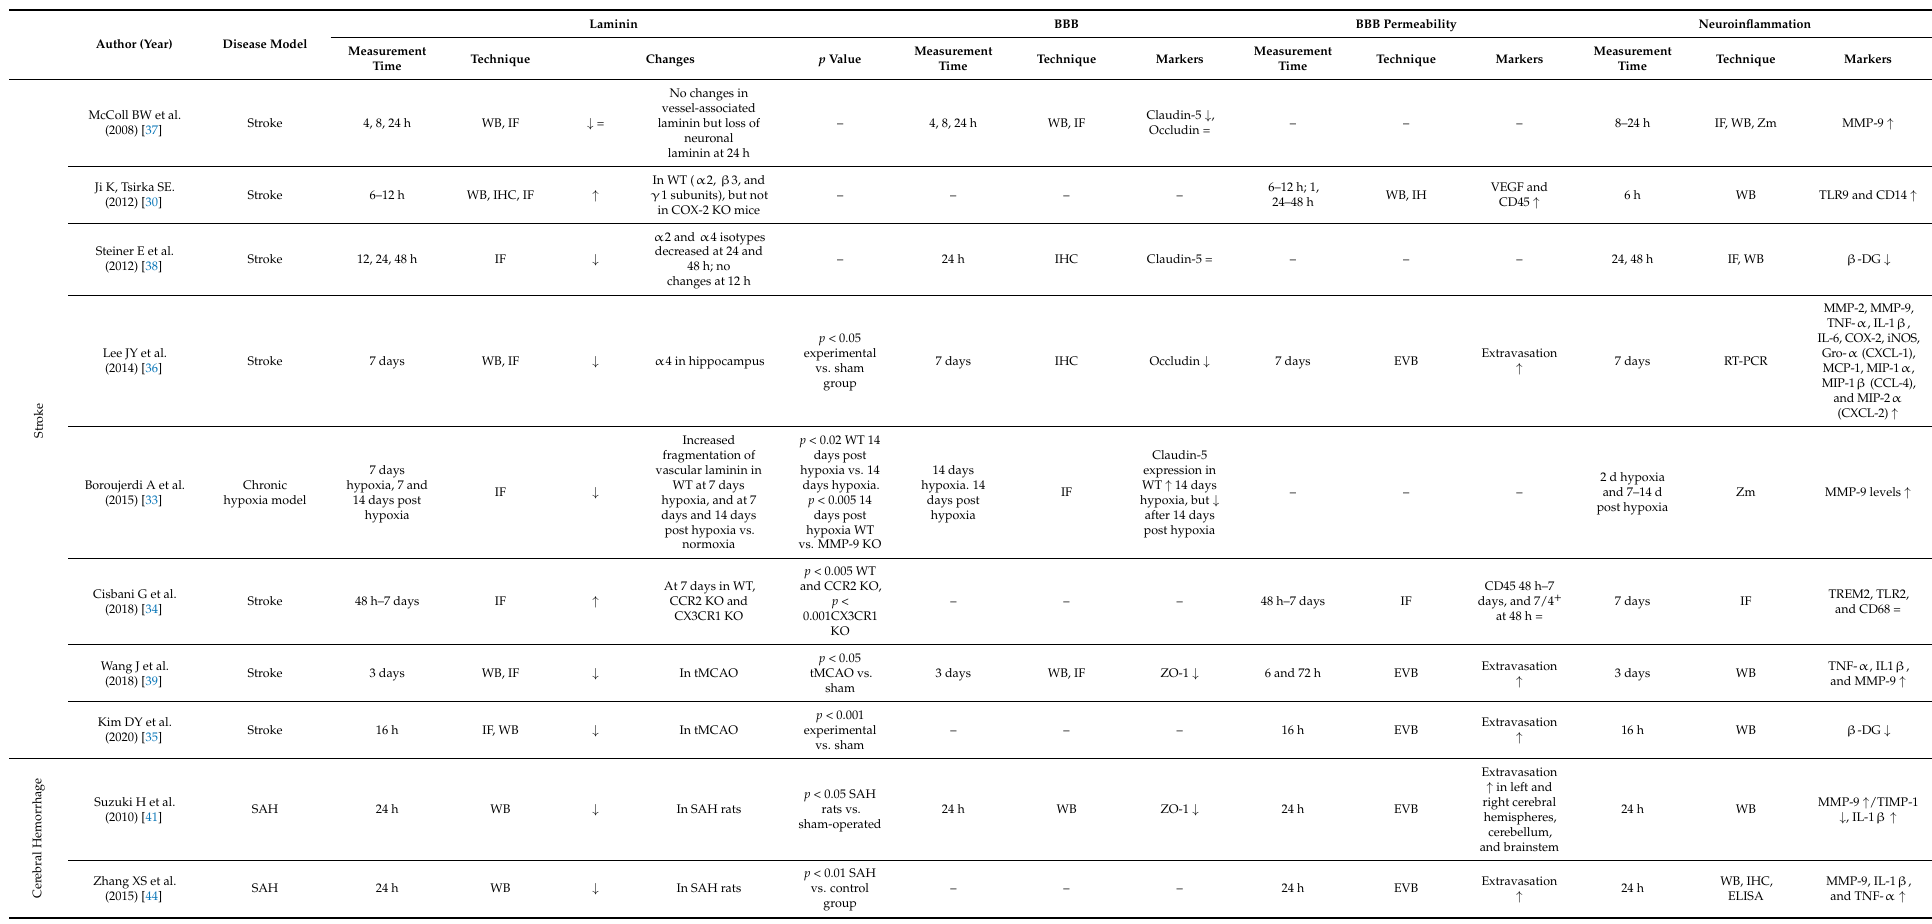
Table 4. Changes in laminin, BBB, and